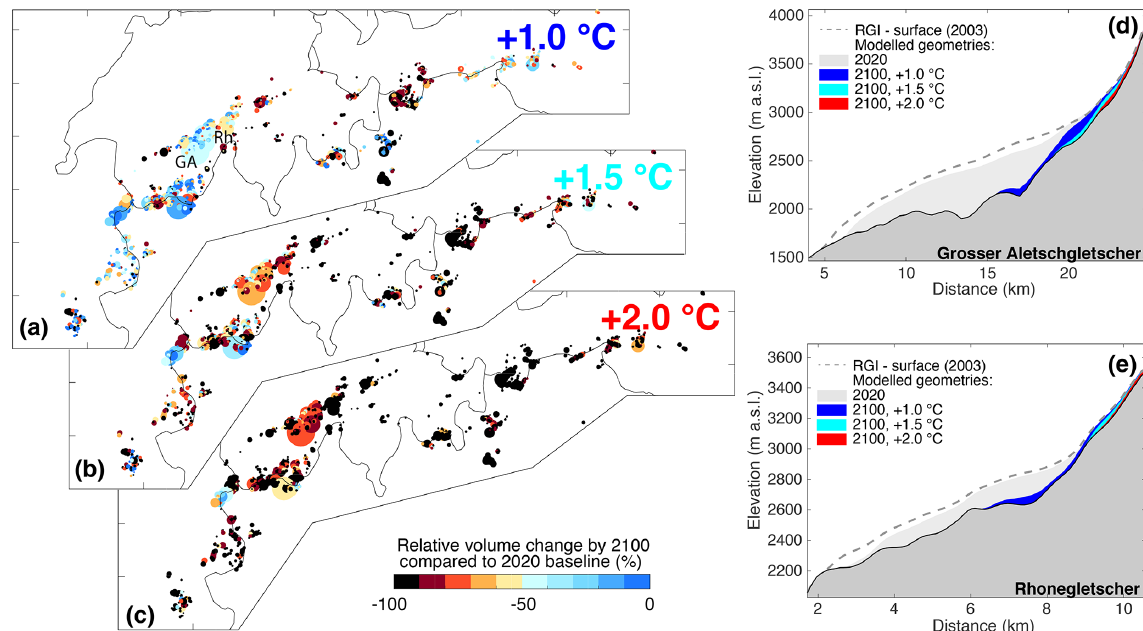
Figure 3. Relative change in glacier volume between 2020 and 2100 for scenarios of (a) + 1.0 ◦ C, (b) + 1.5 ◦ C, and (c) + 2.0 ◦ C of the global temperature increase. Each dot represents one glacier, with the dot’s size being proportional to the glacier area as given by the Randolph Glacier Inventory. The labels “GA” and “Rh” identify the “Grosser Aletschgletscher” and “Rhonegletscher”, respectively. The modelled geometries of these two glaciers are shown in panels (d) and (e) at the inventory date (dashed) for the year 2020 (grey) and for the year 2100 under the three selected scenarios